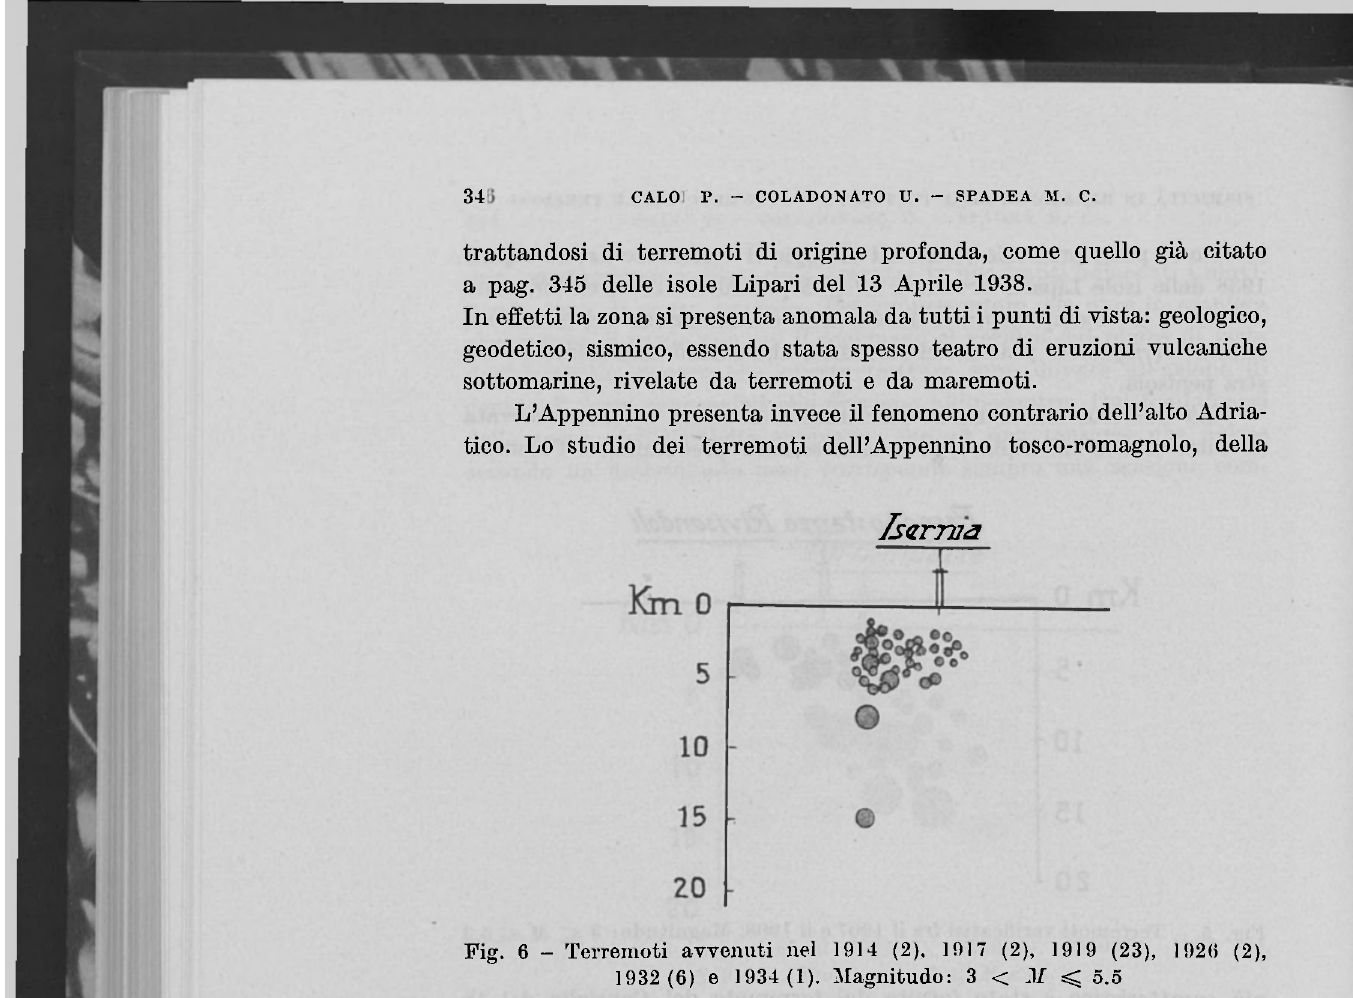
Fig. 6 - Terremoti avvenuti nel 1914 (2), 1917 (2), 1919 (23), 1926 (2), 1932 (6) e 1934 (1). Magnitudo: 3 < M <